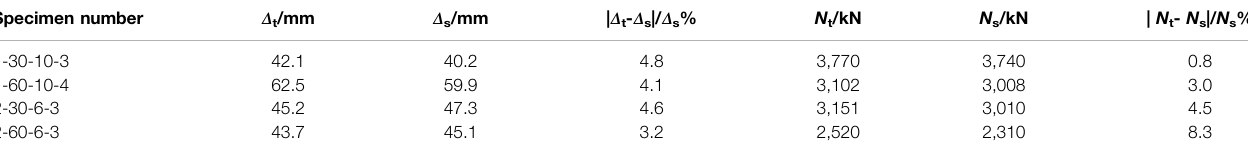
TABLE 5 | Comparisons of ultimate eccentrical compression bearing capacity and ultimate